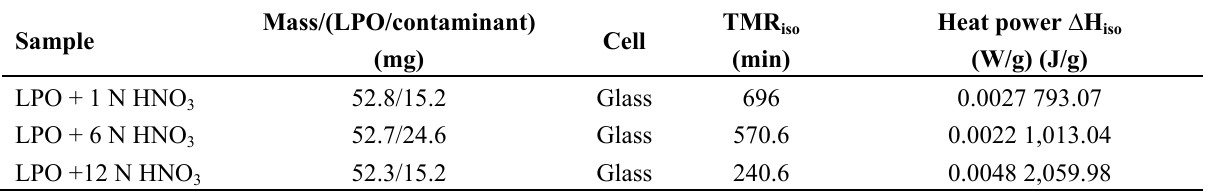
Table 2. Experimental data by TAM III tests for 95 mass% LPO with various concentrations of HNO at 50 °C. 3